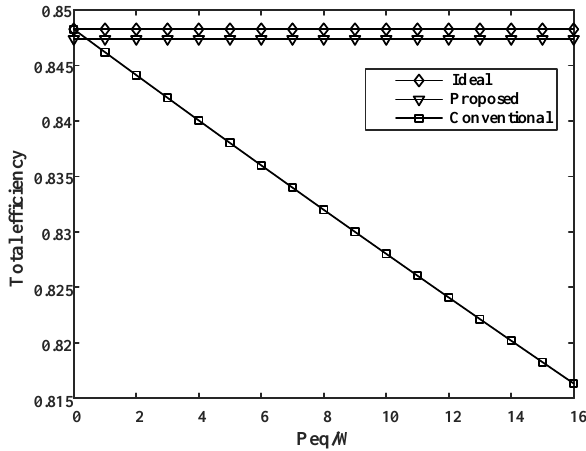
Figure 10. The total efficiency versus the equalization power